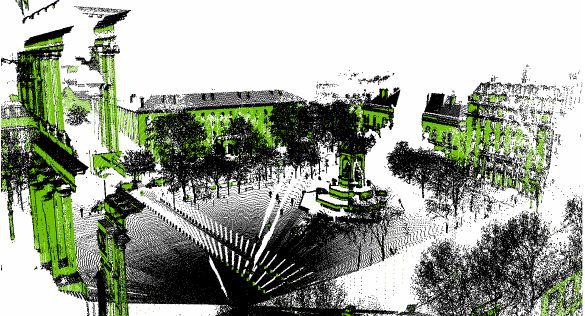
Figure 4: Binary threshold. Points belonging to a façade in green and points not belonging to a façade in at c